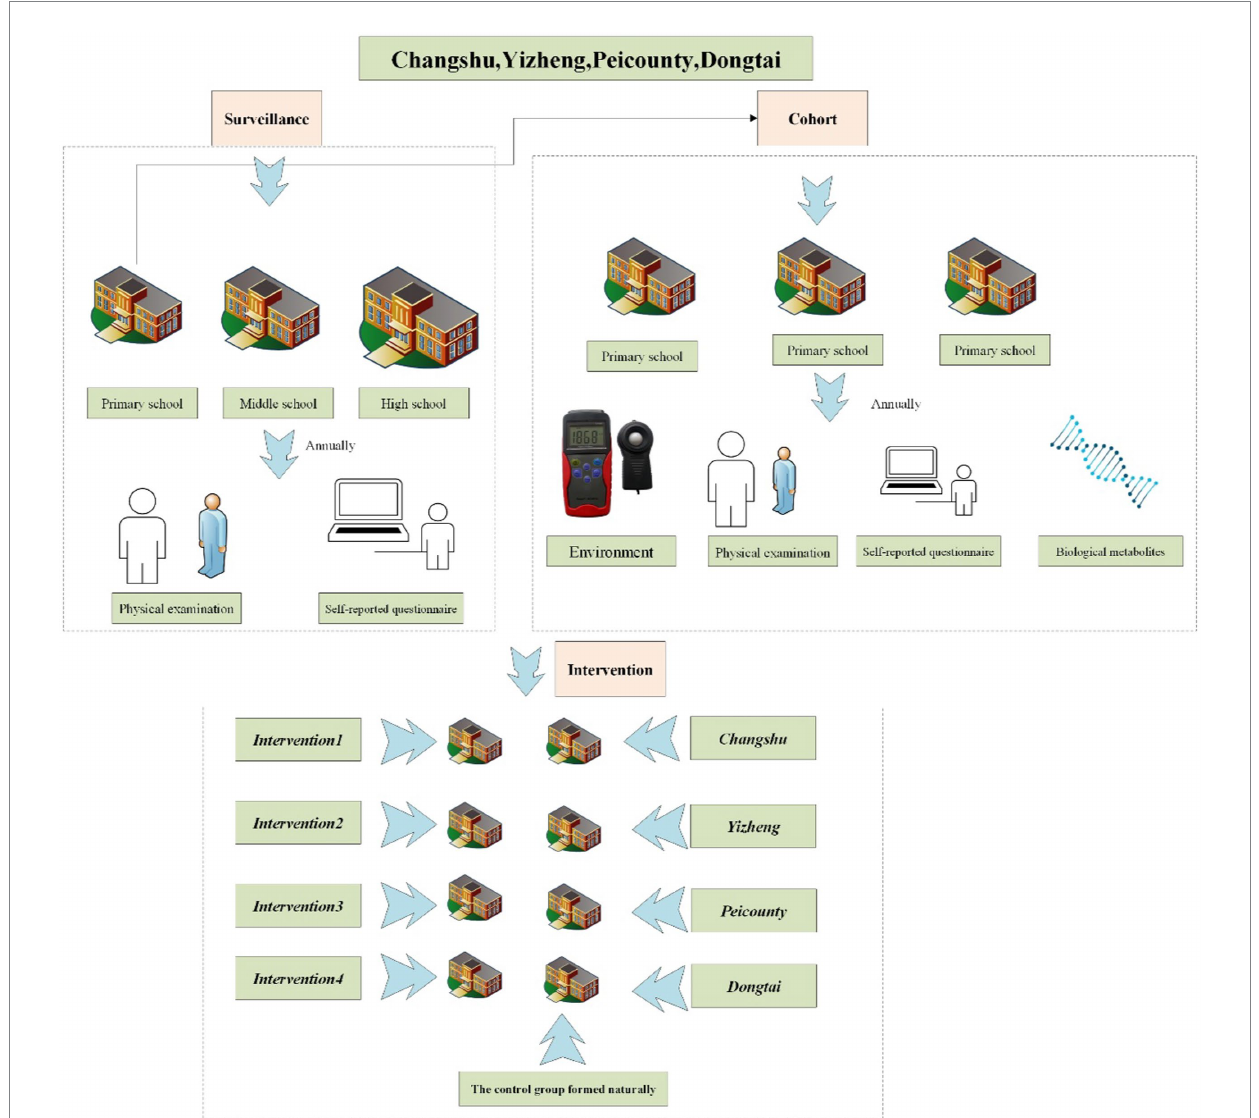
FIGURE 2 The flowchart of the organization, management, and implementation in the ES-SCI Study (Eastern Chinese Students common disease Surveillance, Cohort, and Intervention study).